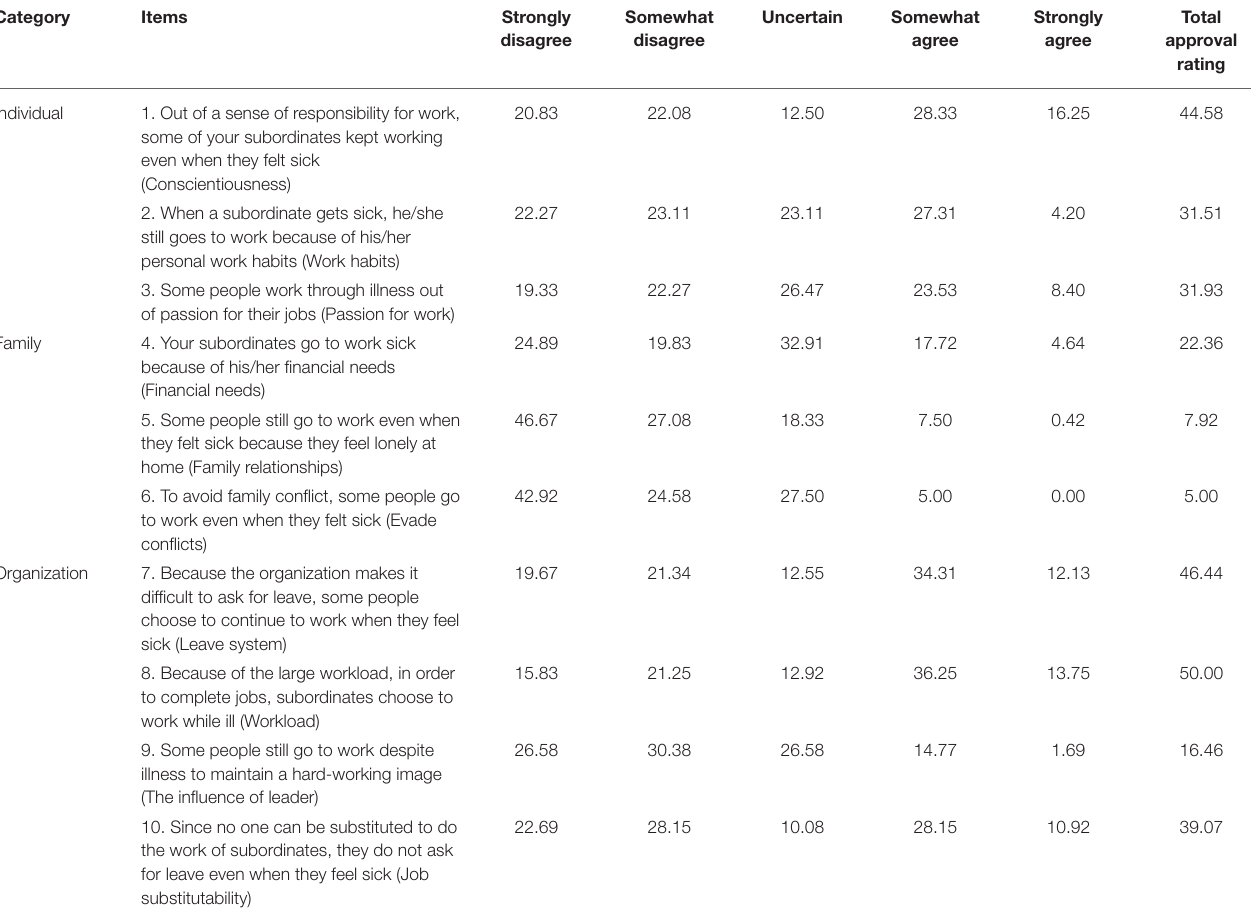
TABLE 4 | Approval rating of presenteeism causes among chief nurses (%).